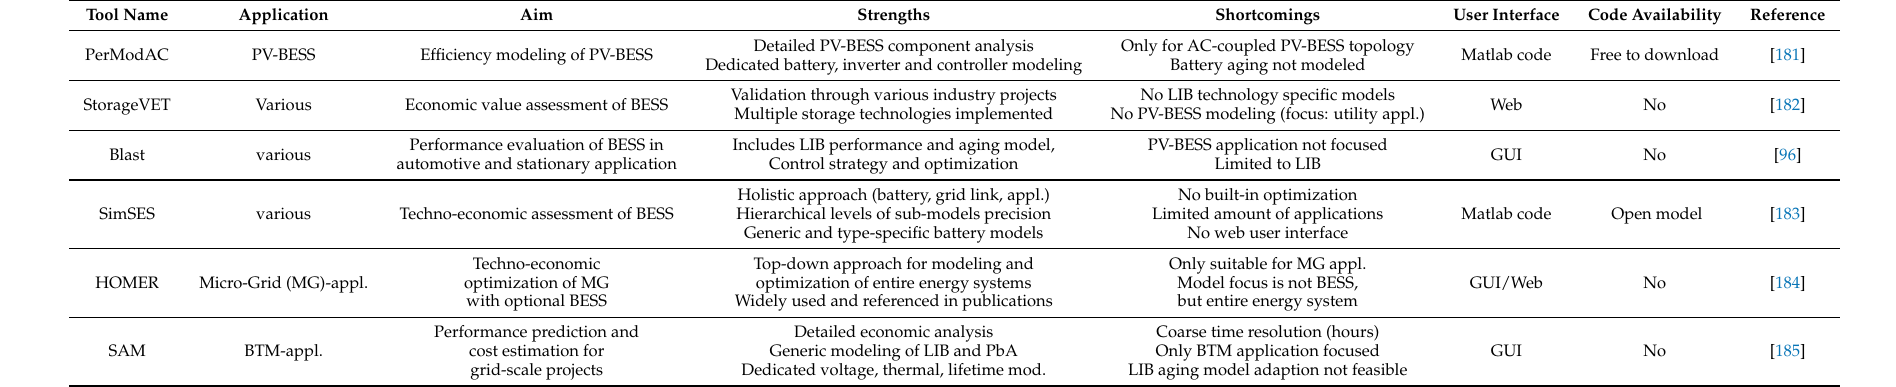
Table 6. Publicly available modeling tools for application-specific storage